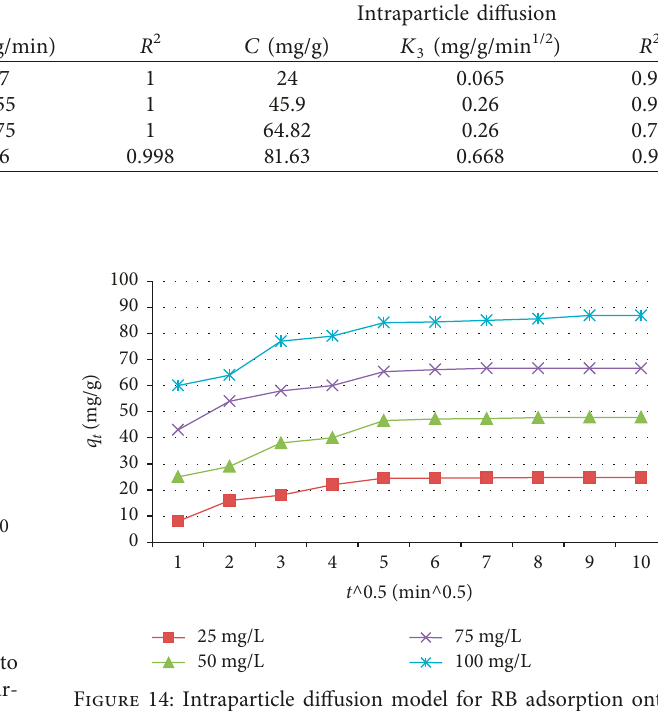
3, and sur- (cid:30)